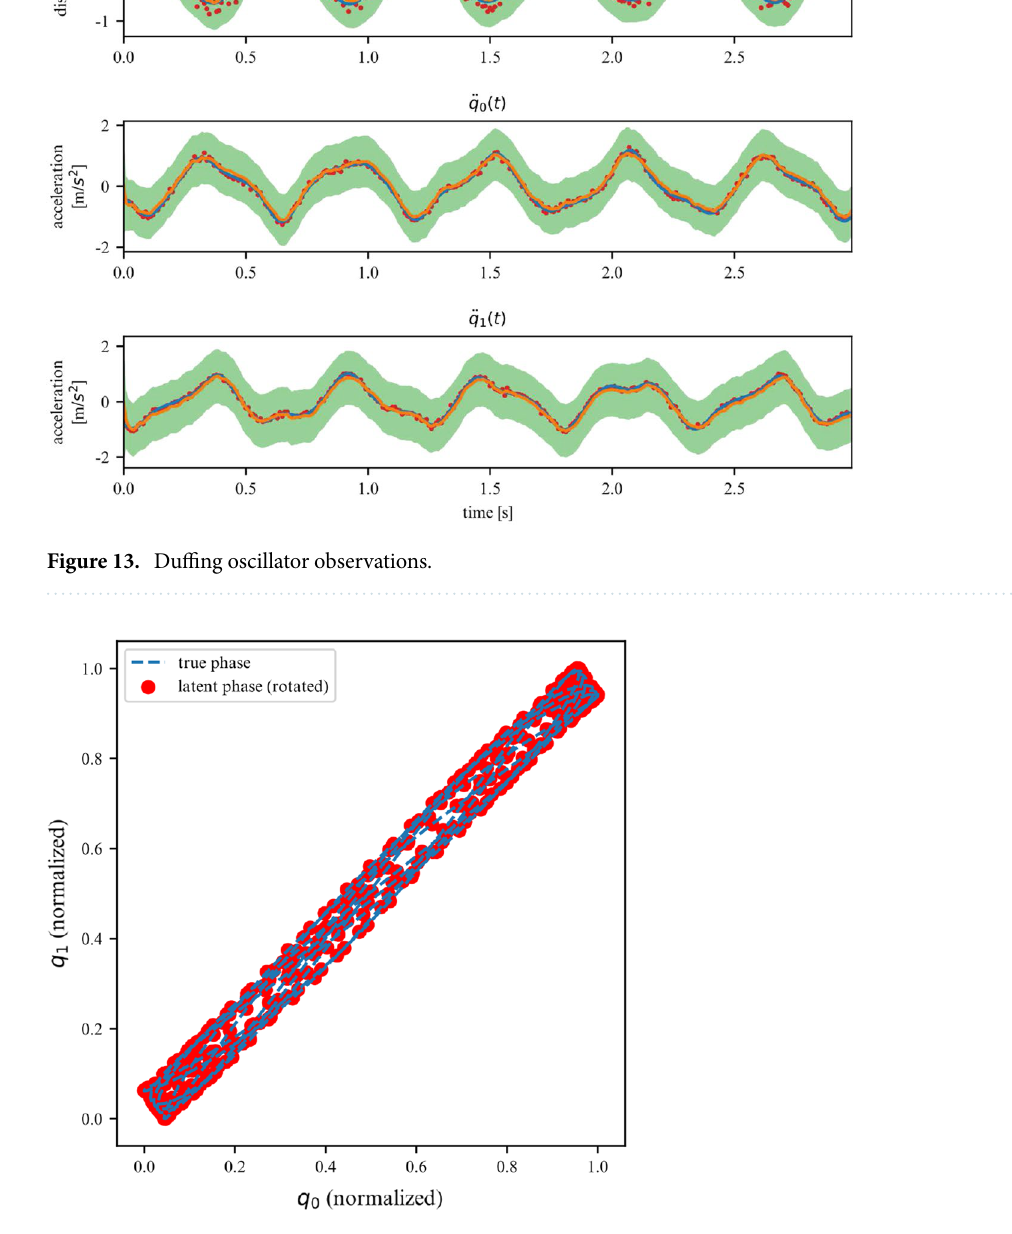
Figure 14. Duffing oscillator phase